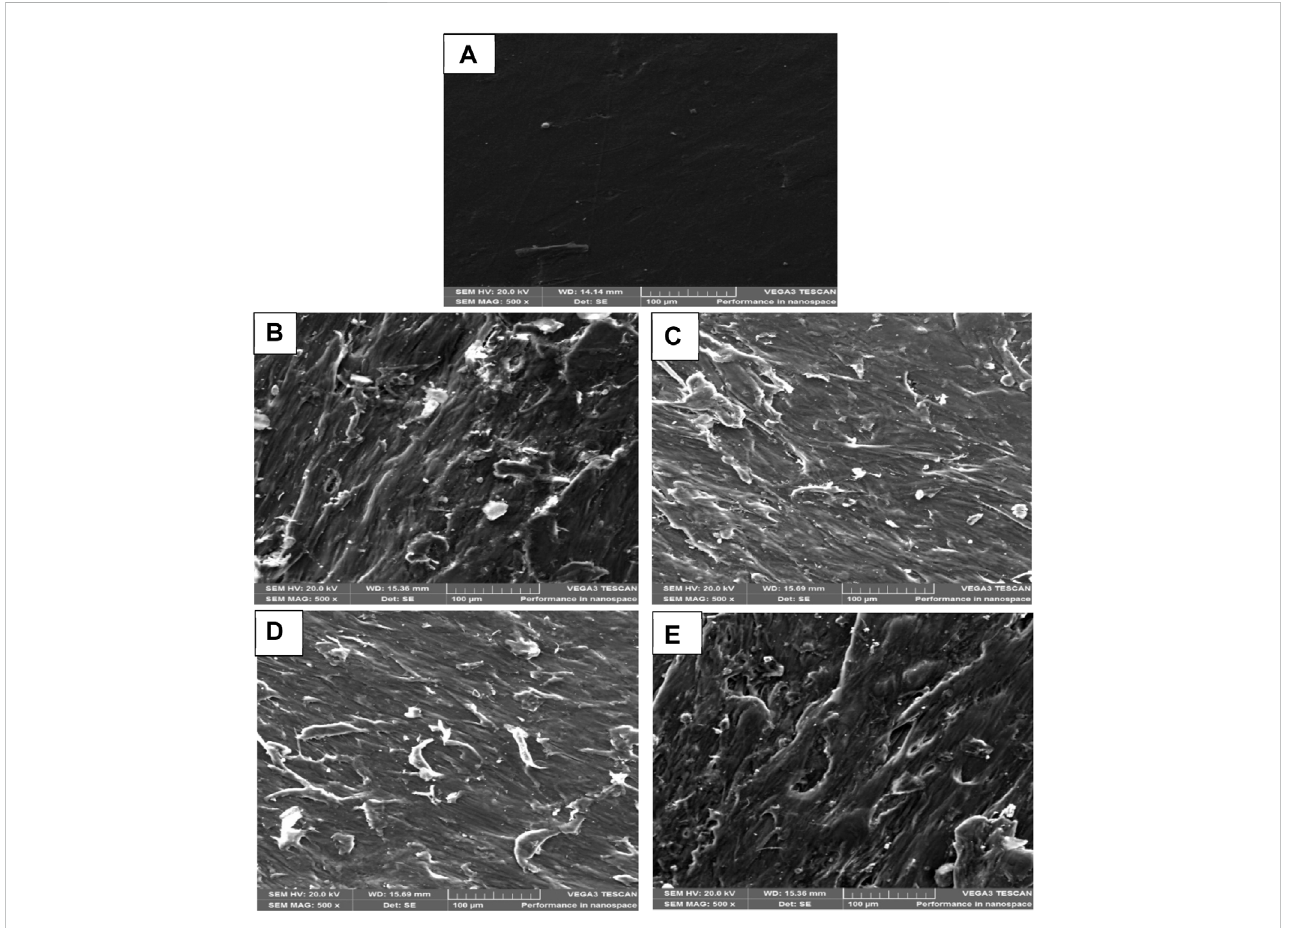
SEM Micrographs of the (A) pure PVDF (B) PVDF-0.05wt%CNTs-5wt%BN (C) PVDF-0.05wt%CNTs-10wt%BN (D) PVDF-0.1wt%CNTs-5wt%BN and (E) PVDF-0.1wt%CNTs-10wt%BN